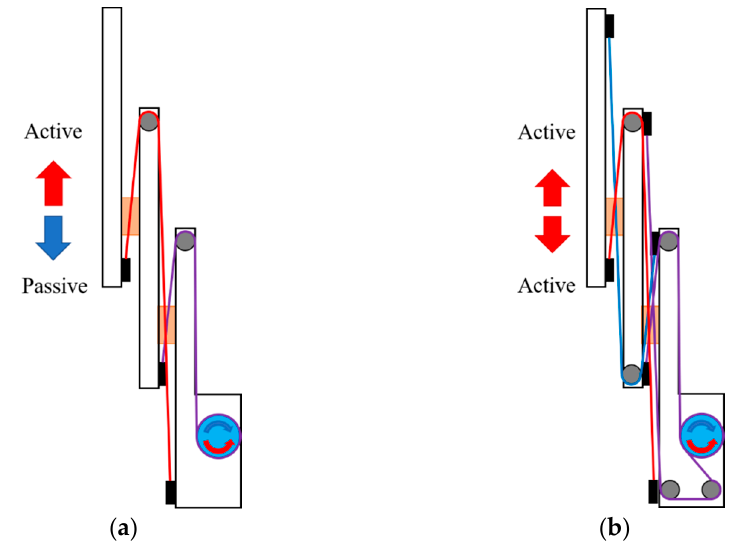
Figure 2. Wire connections comparison: ( a ) one-directional telescopic mechanism; ( b ) bidirectional telescopic mechanism. Sensors 2021 , 21 , 3498 Table 1. Configuration parameters of the end effector.